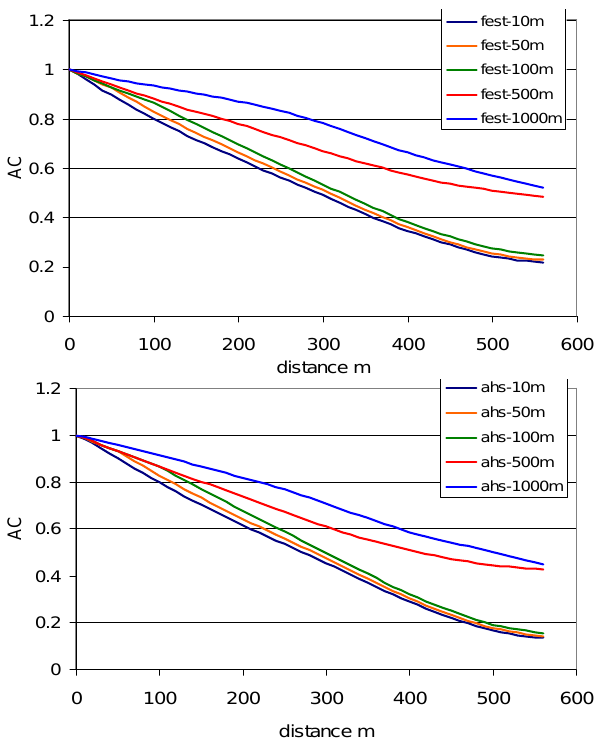
Fig. 8. Comparison between autocorrelation functions for LST maps from FEST-EWB model at different spatial resolution of 10m, 50m, 100m, 500m and 1000m.